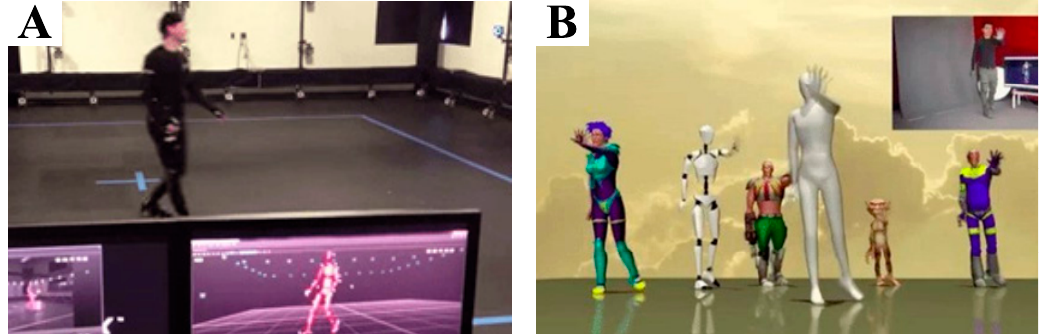
Figure 14. ( A-B ) IoT sensor-based virtual character construction.